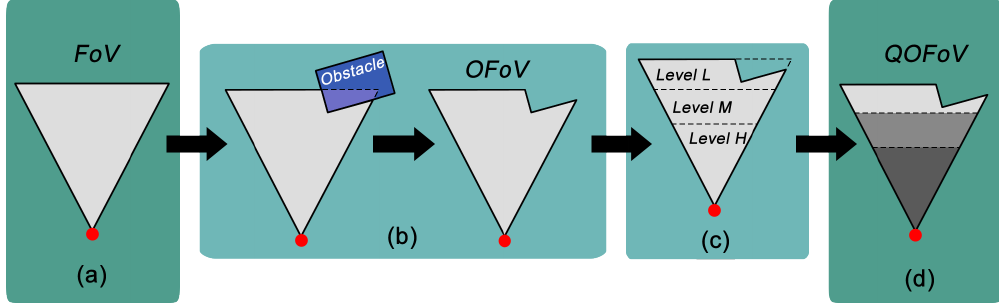
Figure 8. A sensor’s field of view in different processing steps: ( a ) Original coverage, ( b ) Field of View (FoV) under occlusion, ( c ) Quality of Monitoring (QoM)-aware FoV and ( d ) Quality-Occluded FoV (QOFoV) for both occlusion and QoM-aware